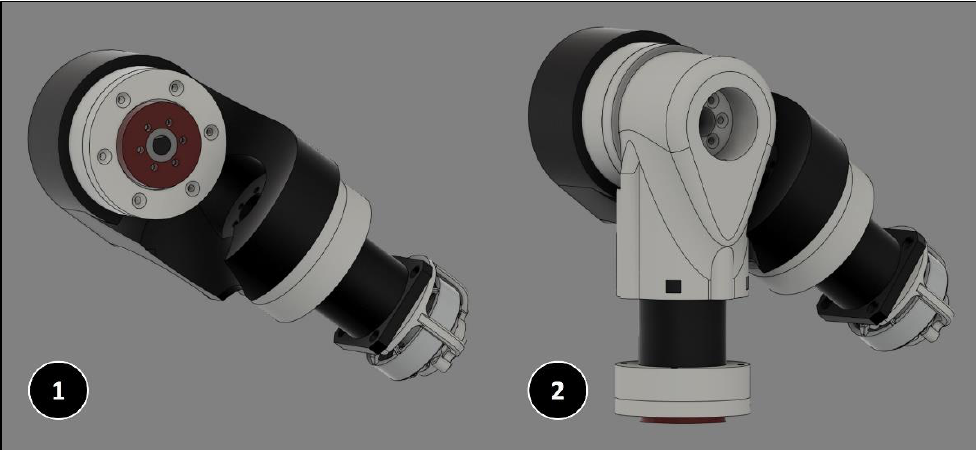
Figure 3. Design of the shoulder joint (1) and of the upper arm axis